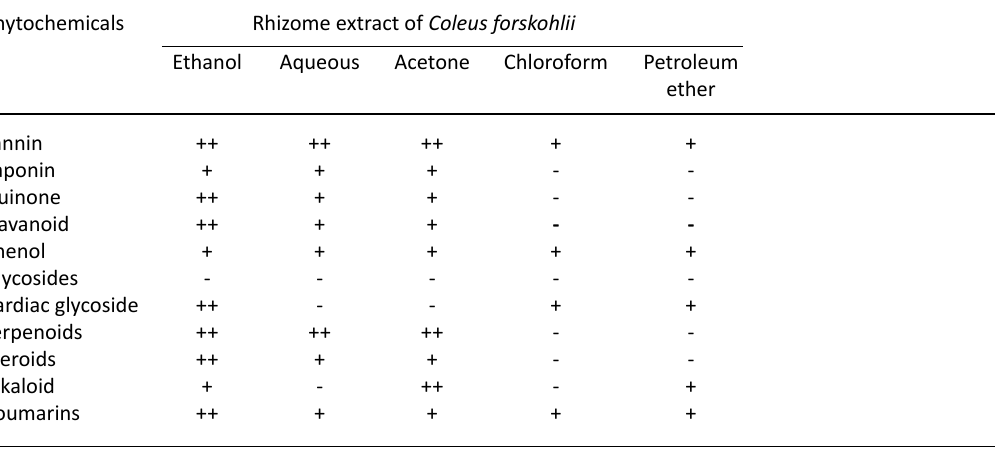
Table 1. Phytochemical screening from rhizome extract of Coleus forskohlii